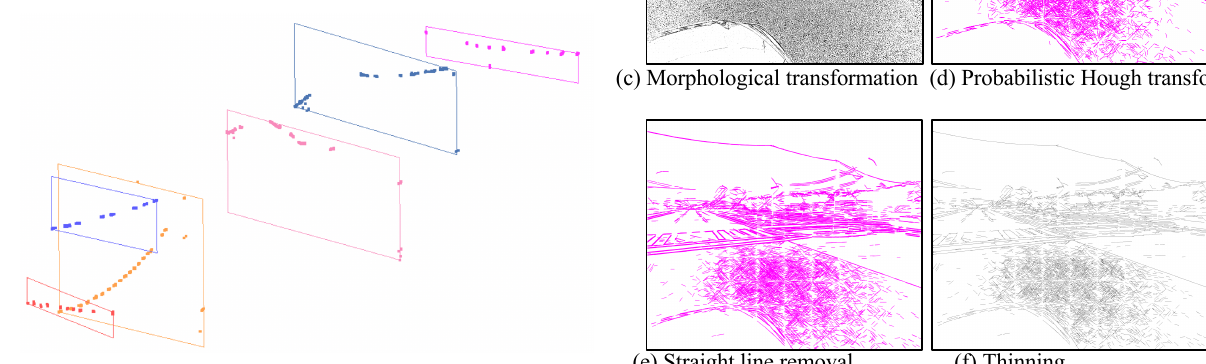
Figure 12. Cable planes Figure 13. Process for line